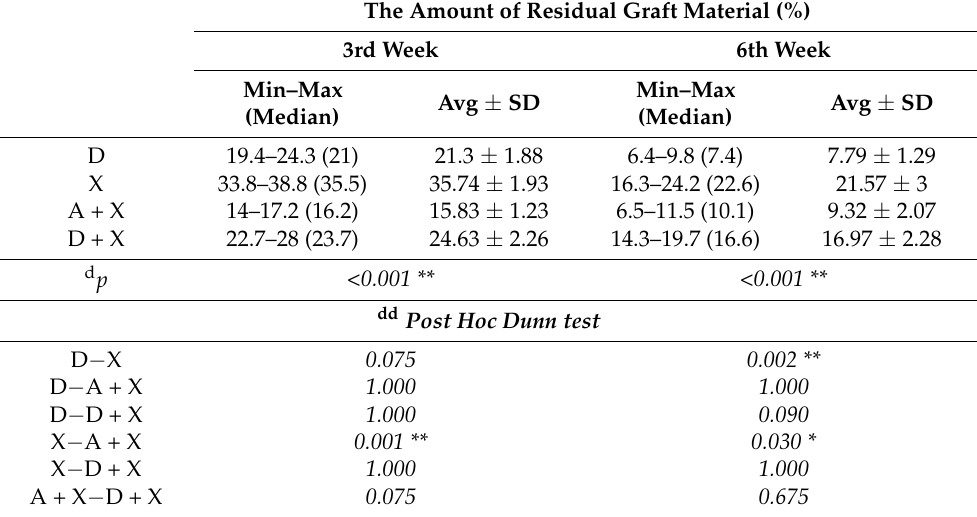
Table 2. The evaluation of the amount of residual graft material by